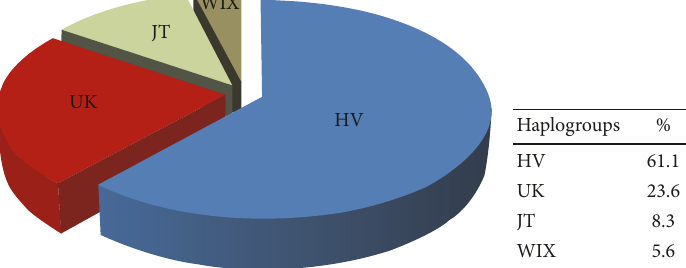
Figure 2: Distribution of sample haplogroups among cancer patients . A total of 72 individuals diagnosed with various cancers have been subjected to haplogroup analyses (%). JT includes haplogroups J, JT, and T. Haplogroup A is not included because of its low percentage.